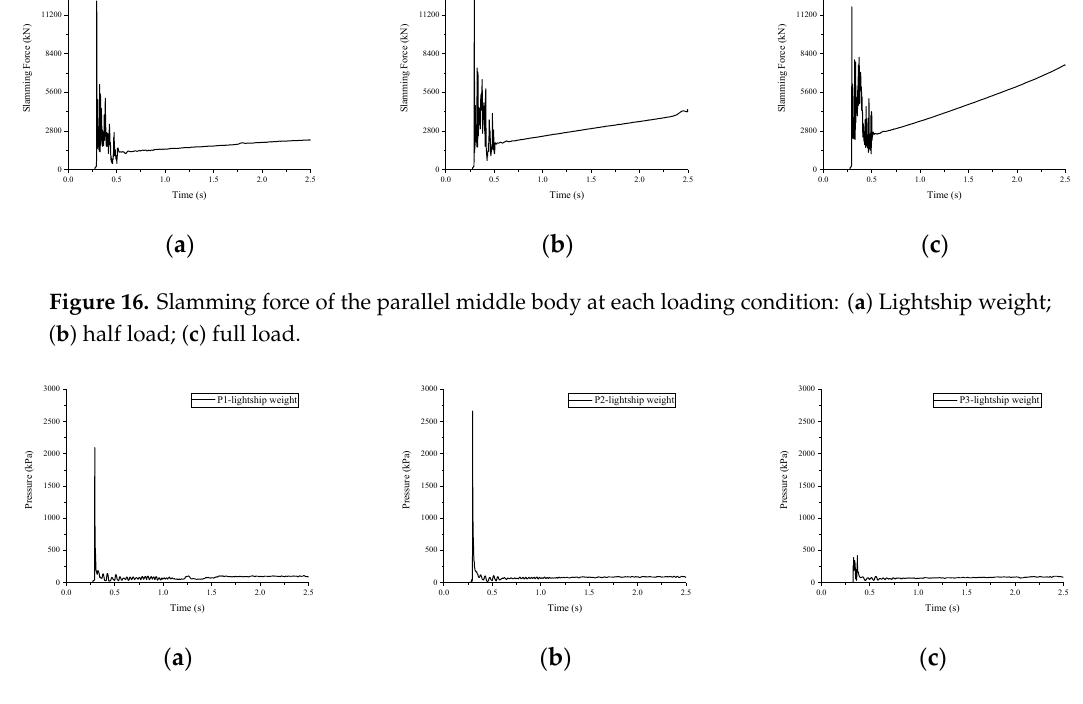
Figure 17. Pressure at P1, P2 and P3 in the case of lightship weight: ( a ) Pressure at P1; ( b ) pressure at P2; ( c ) pressure at P3.